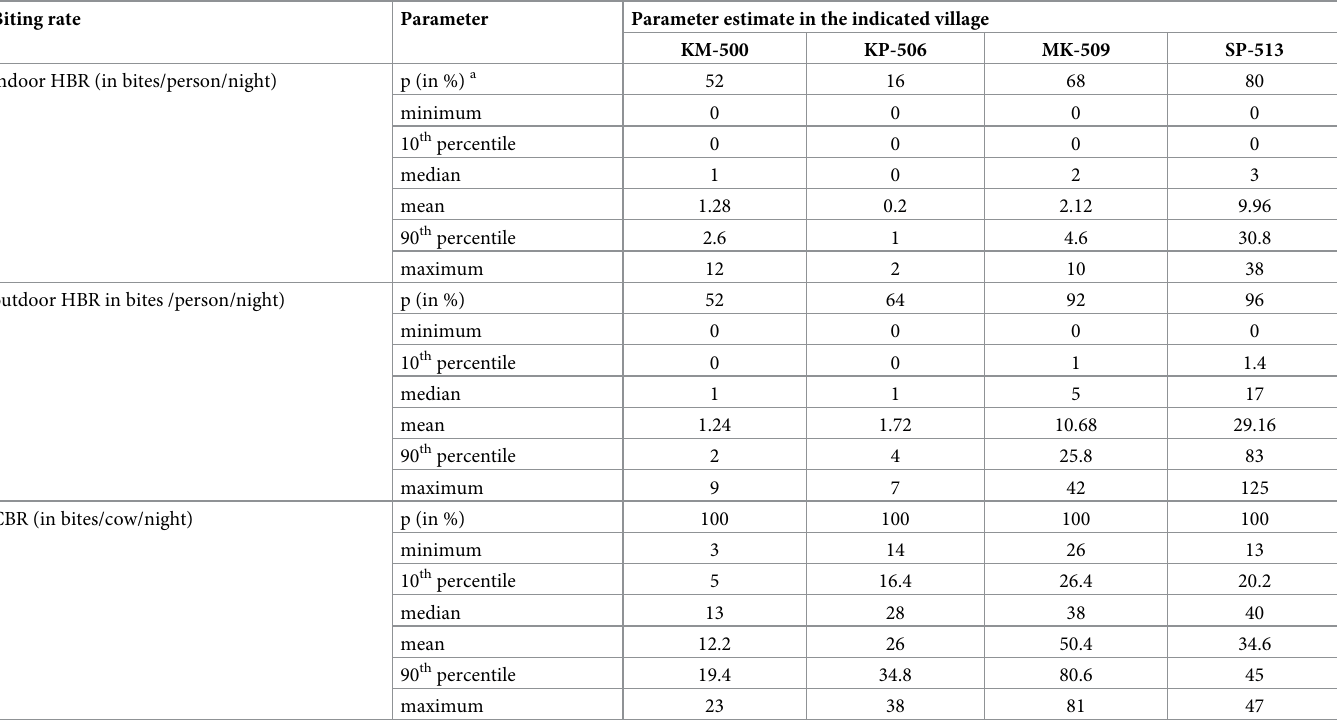
Table 2. Descriptive statistics of malaria vector biting rates at baseline.